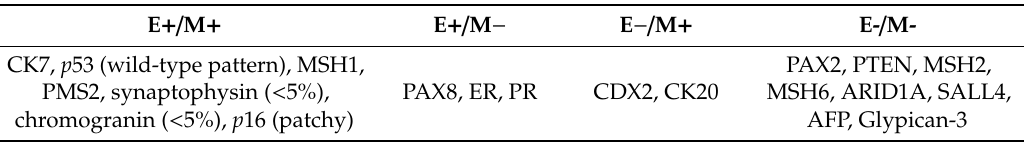
Table 1. Results of immunohistochemical analysis with separate evaluation for endometrioid and mucinous ‐ intestinal tumor components.